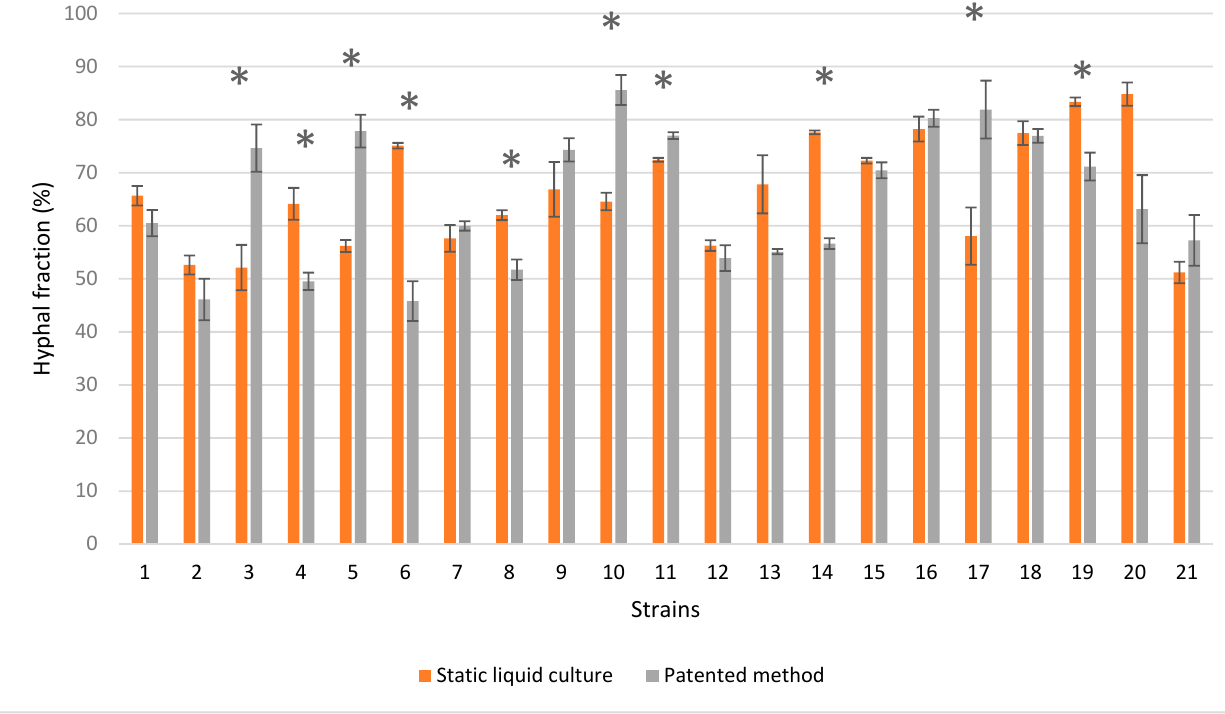
Figure 13. Average ± standard error of hyphal fraction obtained in liquid static culture and by patented method. Signifi- cantly different hyphal fractions are marked by * based on Wilcoxon’s test (* p -value < 0.05).